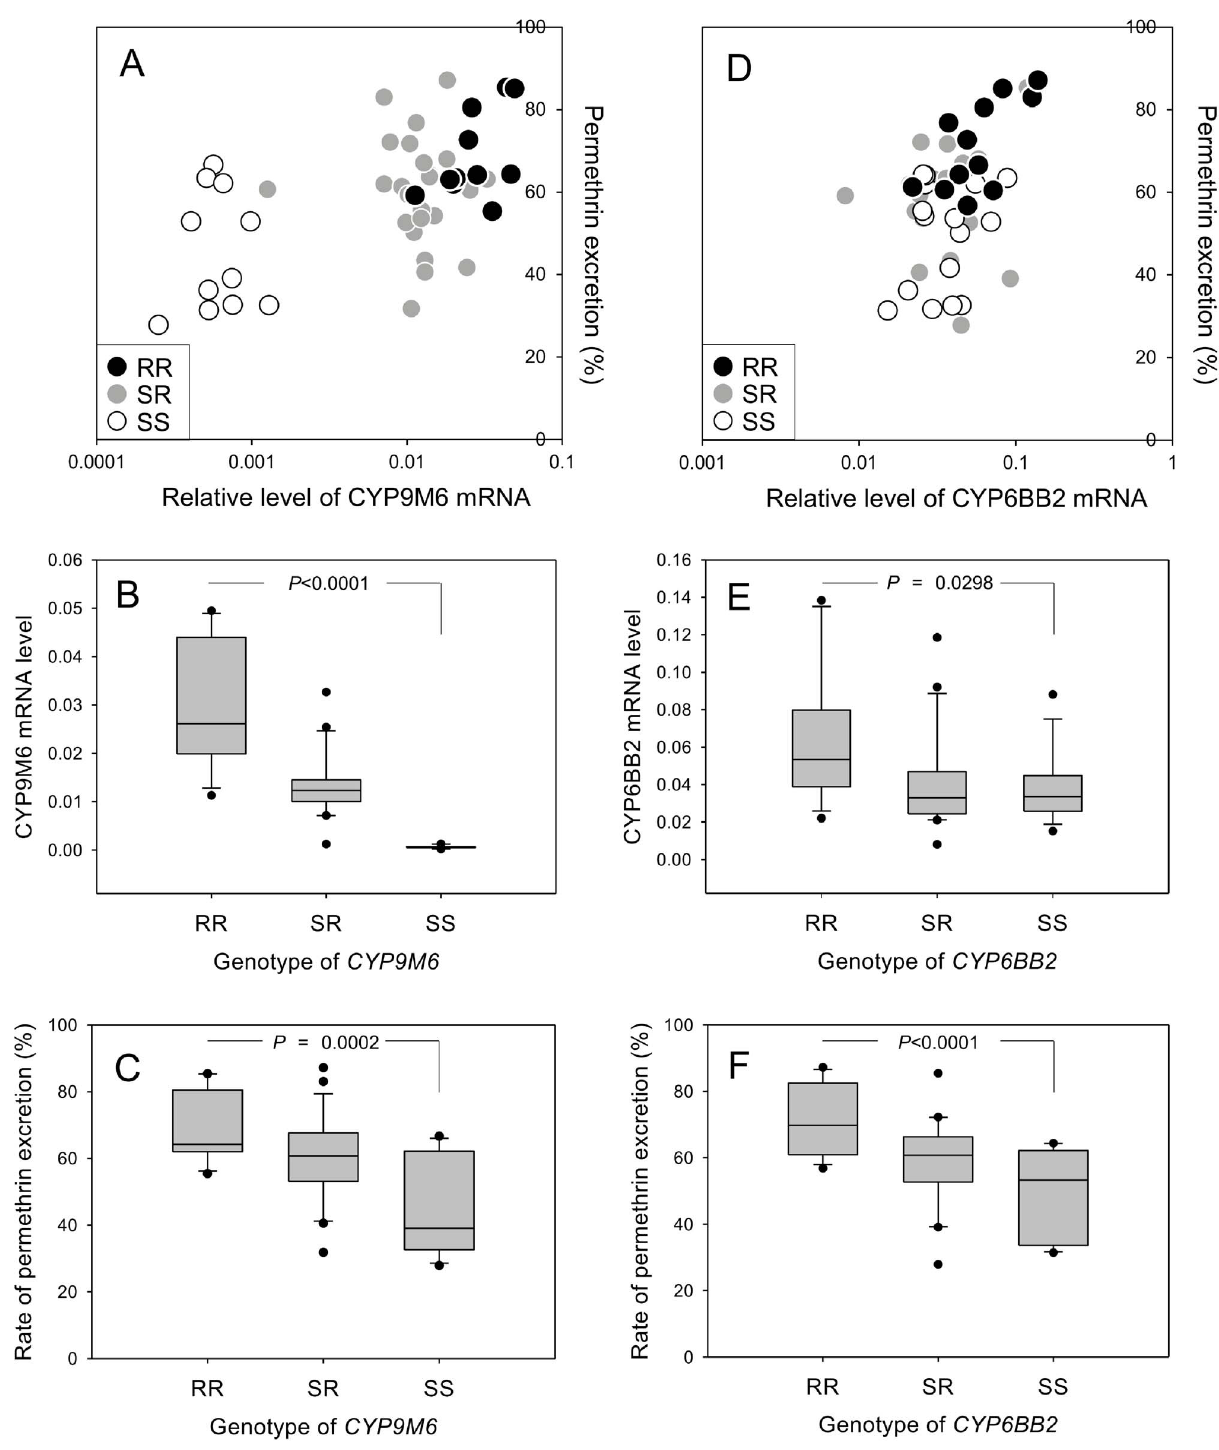
Figure 6. Genotype–gene expression–phenotype associations. The association between CYP9M6 / CYP6BB2 genotypes and mRNA expression and permethrin excretion rate was investigated. The female F2 populations of SP and SMK strains were dosed with [ 14 C]-permethrin, and the amount of permethrin excreted was individually quantified 24 h after treatment. The genotype of each mosquito was identified by the genomic DNA isolated from six legs. mRNA level was also quantified with RNA isolated from the body part of each mosquito. For more information, see Materials and Methods. (A, D) Plot showing the association between the level of mRNA and permethrin excretion in CYP9M6 (A) and CYP6BB2 (D). (B, E) Box plot showing the association between mRNA level and CYP9M6 (B) and CYP6BB2 (E). (C, F) Box plot showing the association between permethrin excretion rate and genotype of CYP9M6 (C) and CYP6BB2 (F). P -values for comparison of the RR and SS genotypes were calculated using Dunnett’s test.